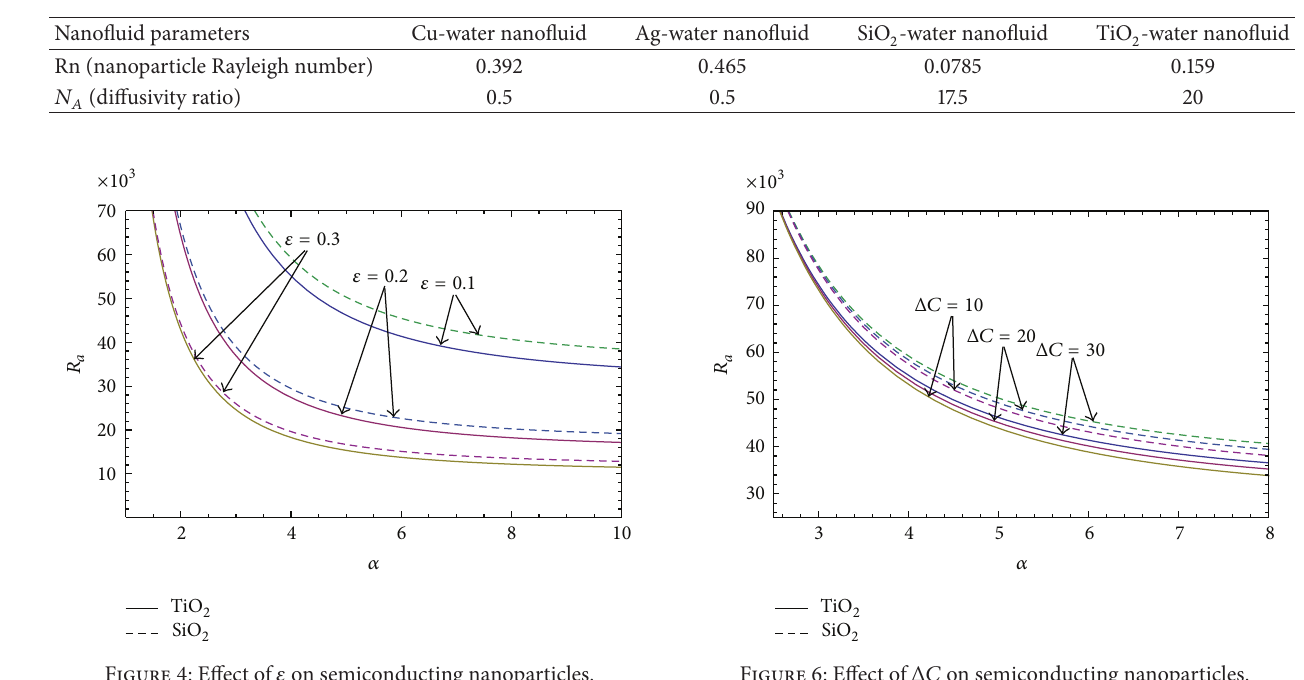
Figure 4: Effect of 𝜀 on semiconducting nanoparticles.